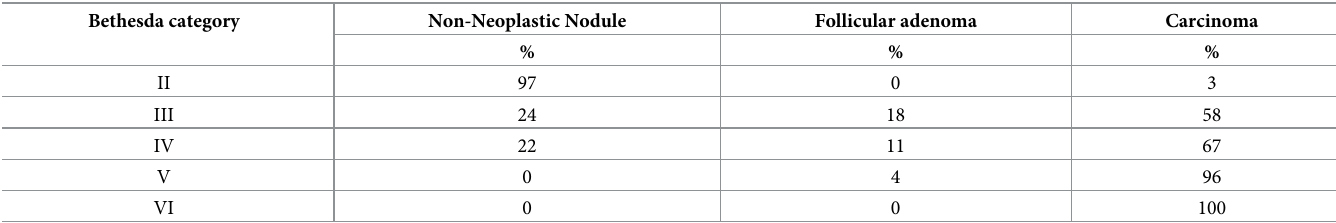
Table 5. Correlation between Bethesda categories and risk of malignancy. Bethesda category